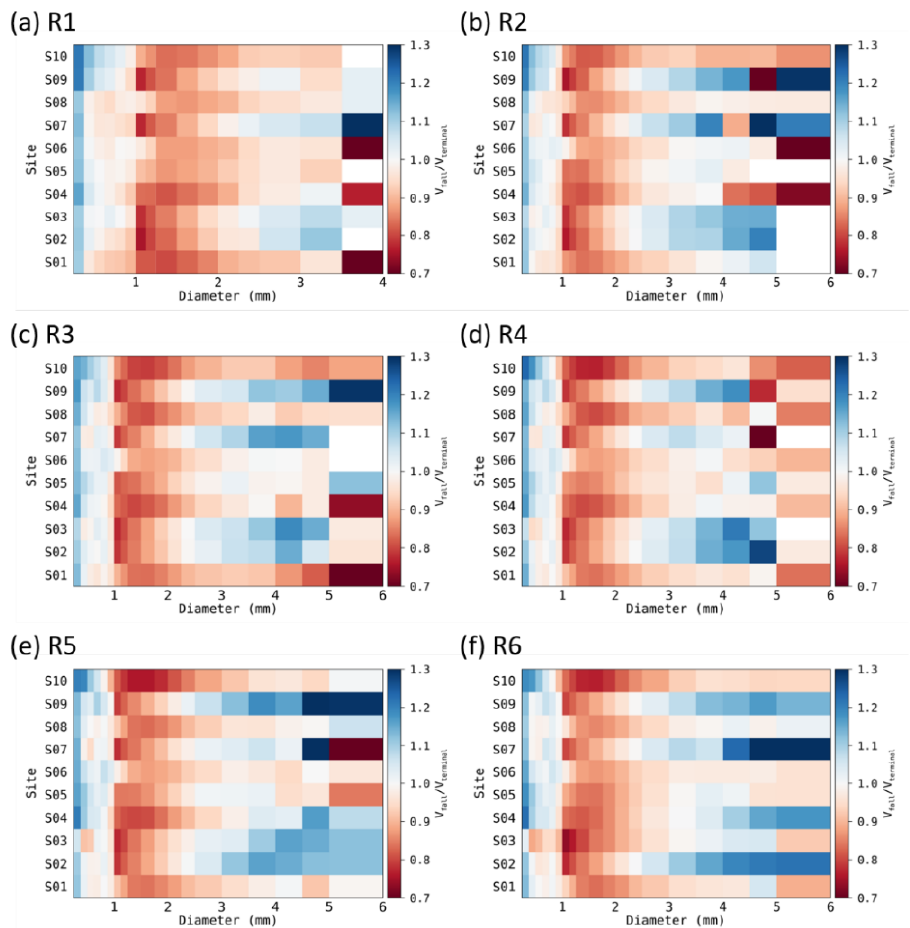
Figure 4. The ratio of fall velocity to terminal velocity of raindrops for rain rate categories at the 10 Parsivel sites.